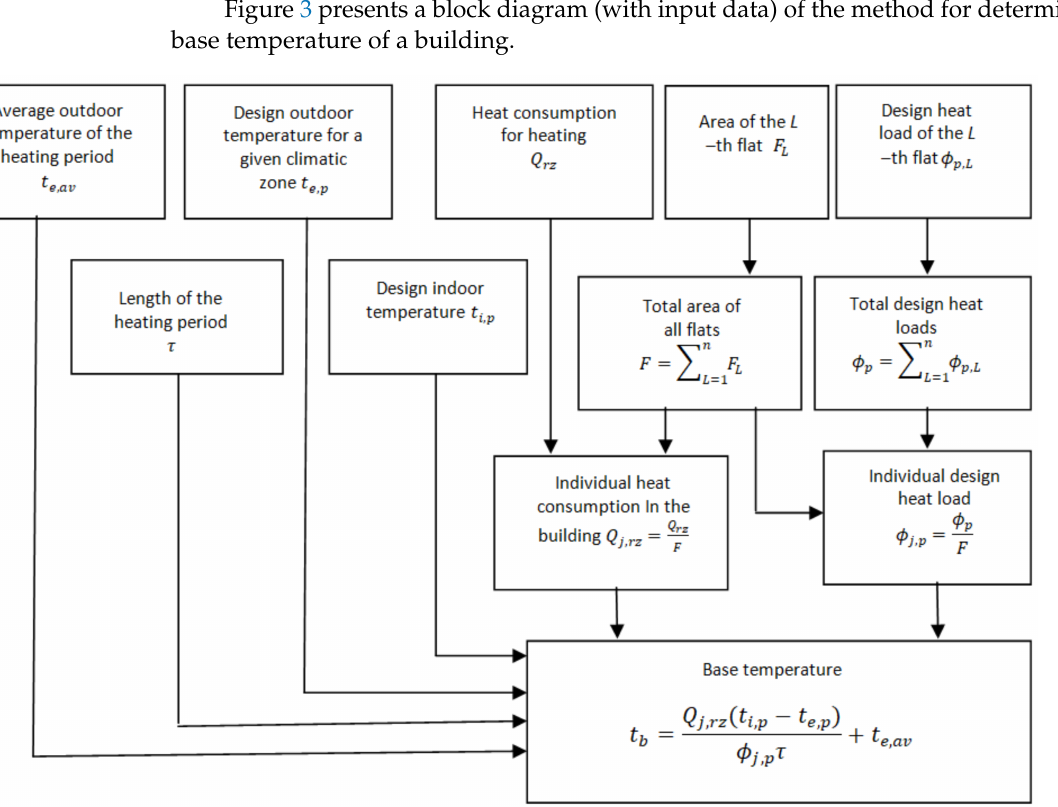
Figure 3. Block diagram of the method for determining the base temperature of a